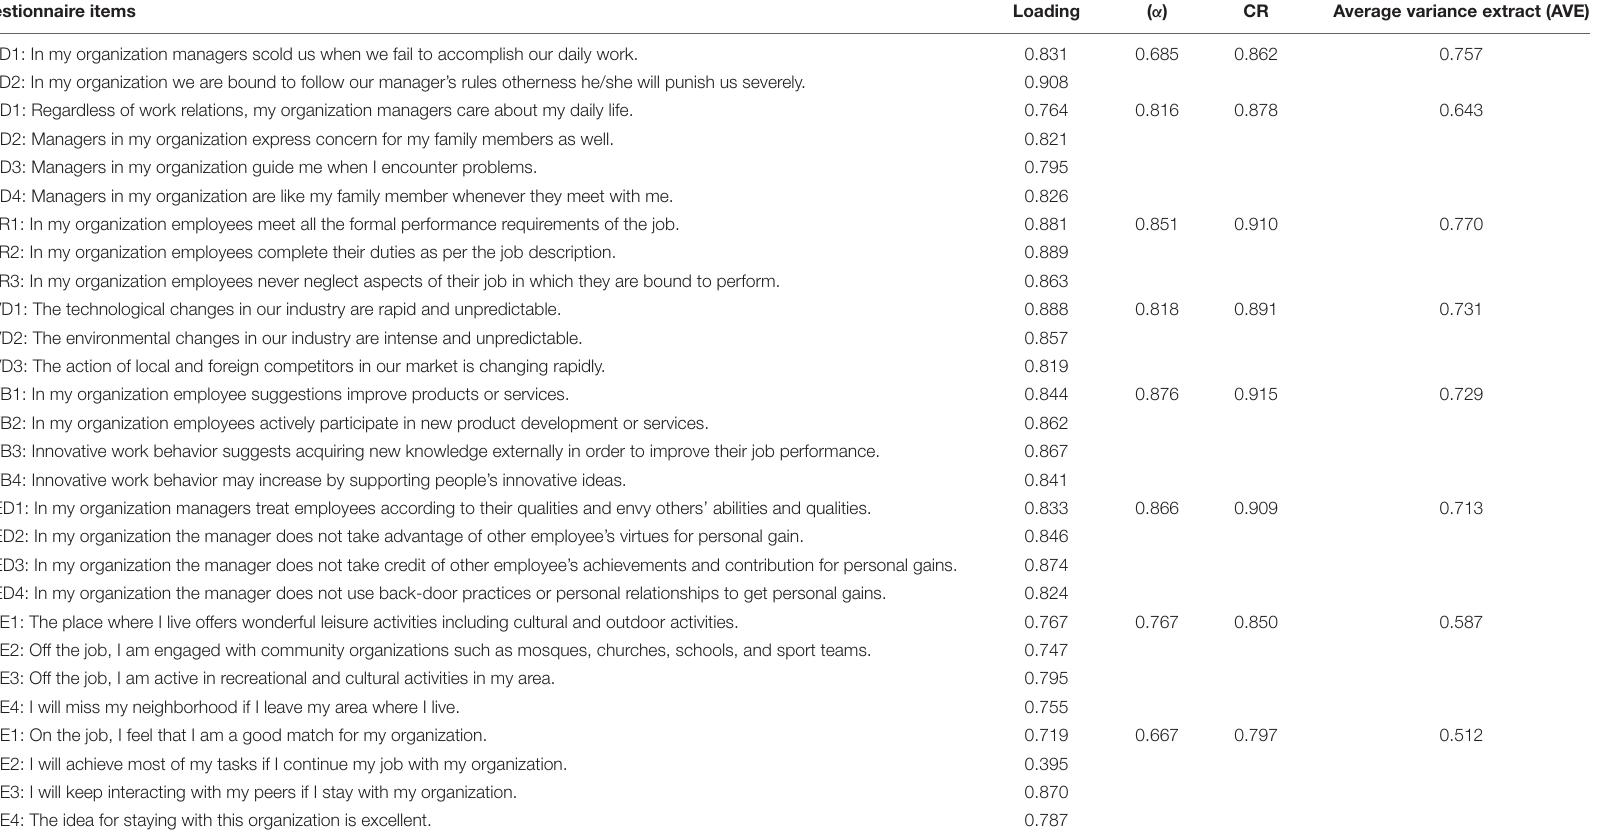
TABLE 1 | Measurement